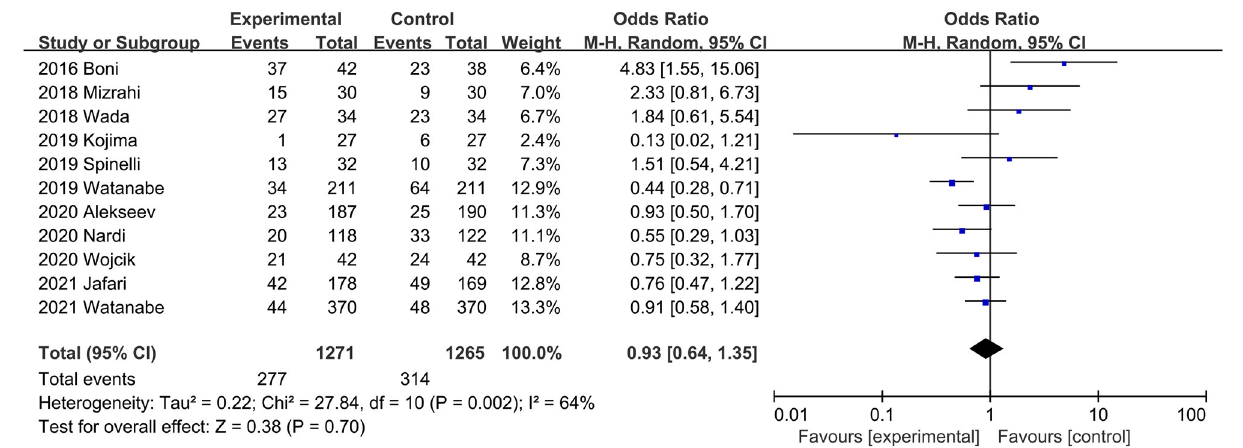
( Figure 9B ). Significant heterogeneity ( P < 0.00001; I 2 = 81%) ( Figure 9B ) was observed between these studies. When